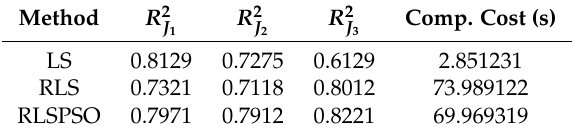
Table 4. Indexes R 2 (Joint 1, 2 and 3) and computational cost of algorithms with noises.